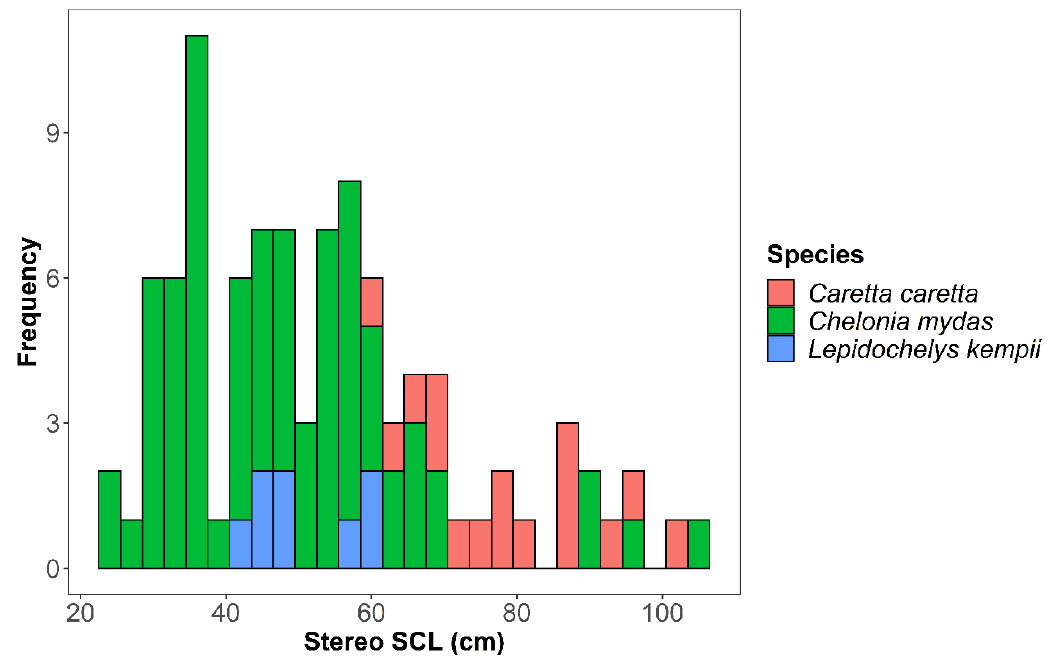
Figure 2. Size frequency distribution of three species of sea turtle observed across study sites in the northern Gulf of Mexico.